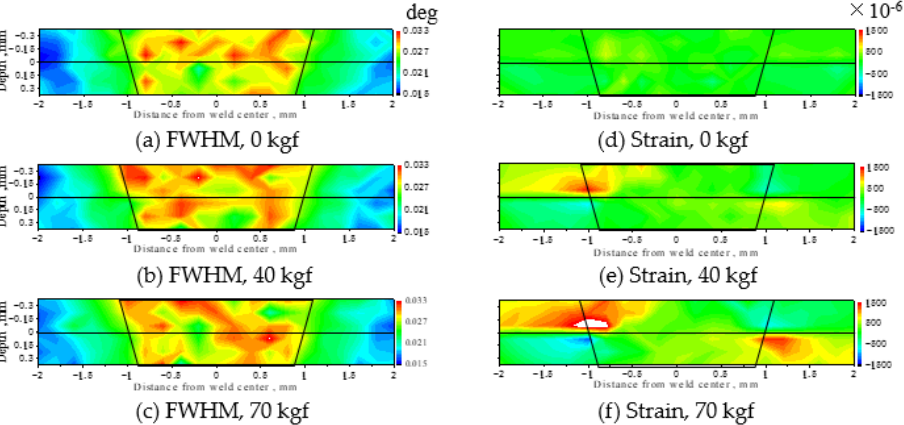
Figure 4. Diffraction profiles of α - Fe211 under a high temperature and tensile load.